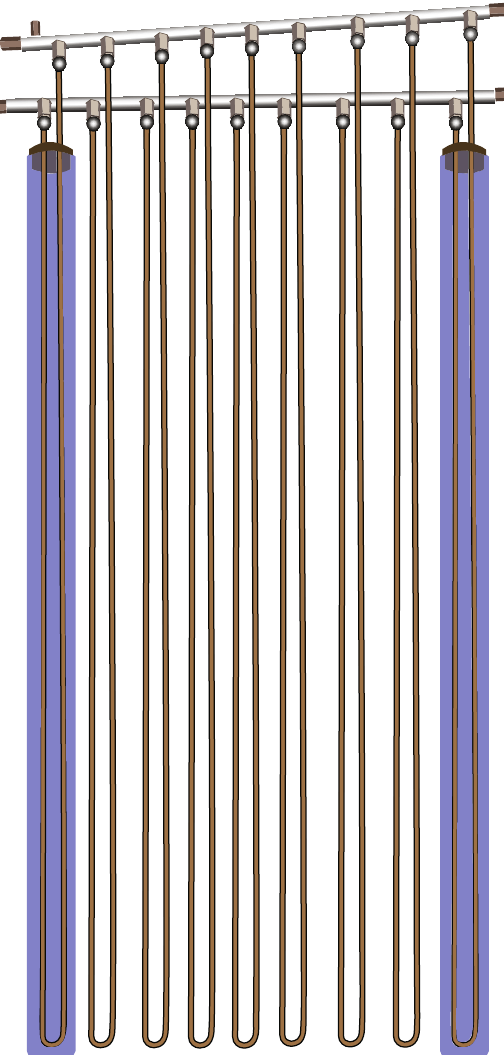
Figure 2: Evacuated glass tube collector with U-shape heat removal